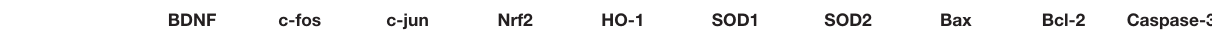
TABLE 8 | Brain tissue mRNA expression in SD